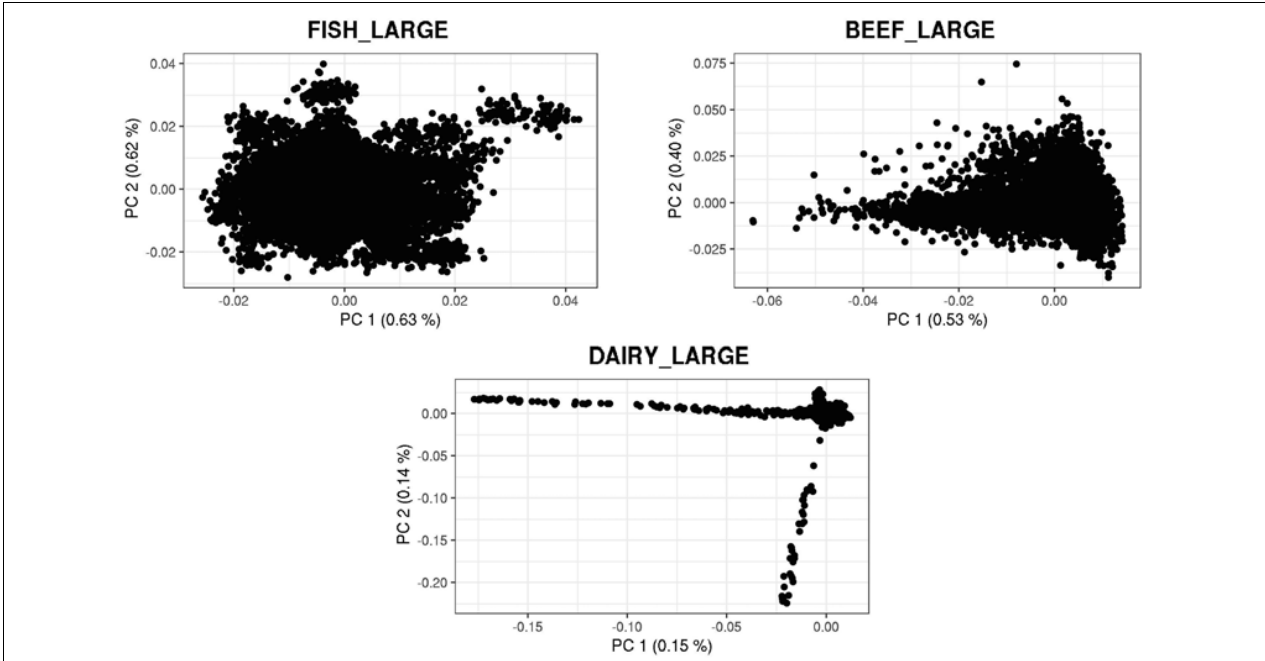
FIGURE 4 | First and second principal components of the genomic relationship matrices for the large populations of fish, beef, and dairy